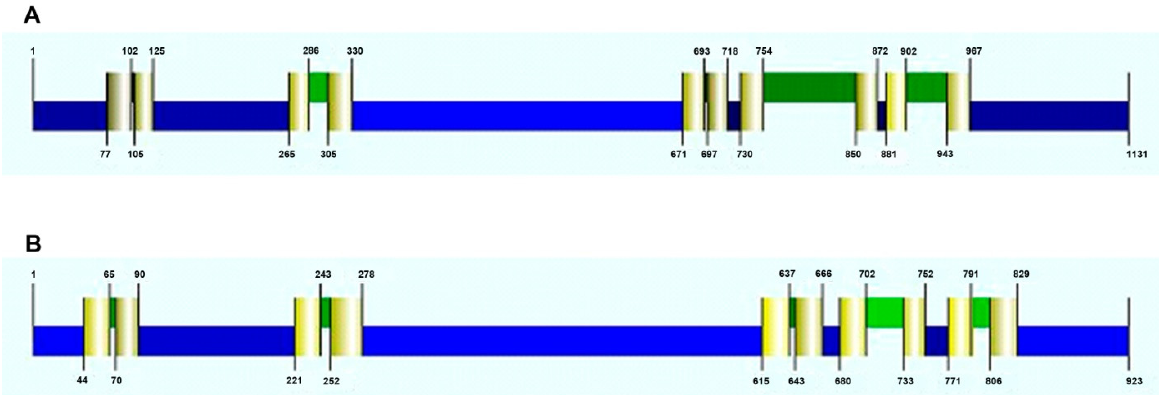
Figure 3. Predicted topology of Dm HA1 (( A ), 1131 aa) and Dm HA2 ATPases (( B ), 923 aa) and the location of the transmembrane domains (TMD) (colored pale yellow). Cytoplasmic areas (N-terminus, small and large cytoplasmic loops, C-terminus) are colored blue, extracellular protein areas are colored green. The figure illustrating the consistent model derived by the CCTOP (Constrained Consensus TOPology) online service (http://cctop.enzim.ttk.mta.hu, accessed on 1 December 2021) is taken from the Philius prediction (http://cctop.enzim.ttk.mta.hu, accessed on 1 December 2021).